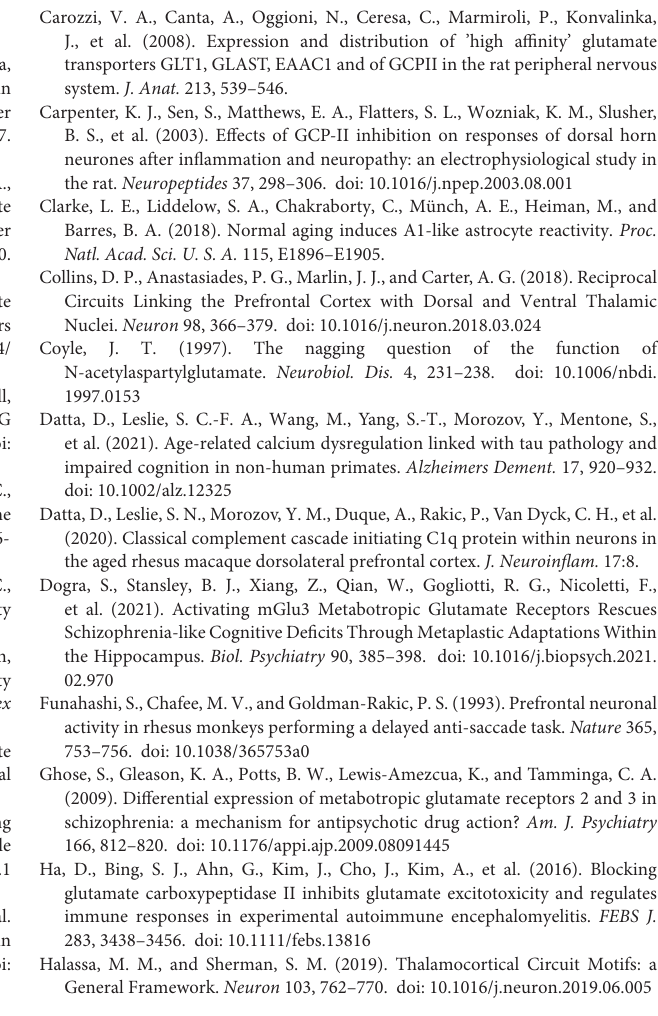
Supplementary Figure 1 | Full western blot membranes. (A) Image of the full nitrocellulose membrane, rather than just the region of interest, from Figure 4 . Rat frontal cortex tissue (18 mg of protein loaded per well) was immunoblotted for GCPII and GAPDH. Each lane represents a single animal and is labeled either young (gray Y) or aged (red A). (B) Image of the full nitrocellulose membrane, rather than just the region of interest, from Figure 5 . Rat frontal cortical tissue (15 mg of protein loaded per well) was immunoblotted for mGluR3 and GAPDH. Each lane represents a single animal and is labeled either young (gray Y) or aged (blue